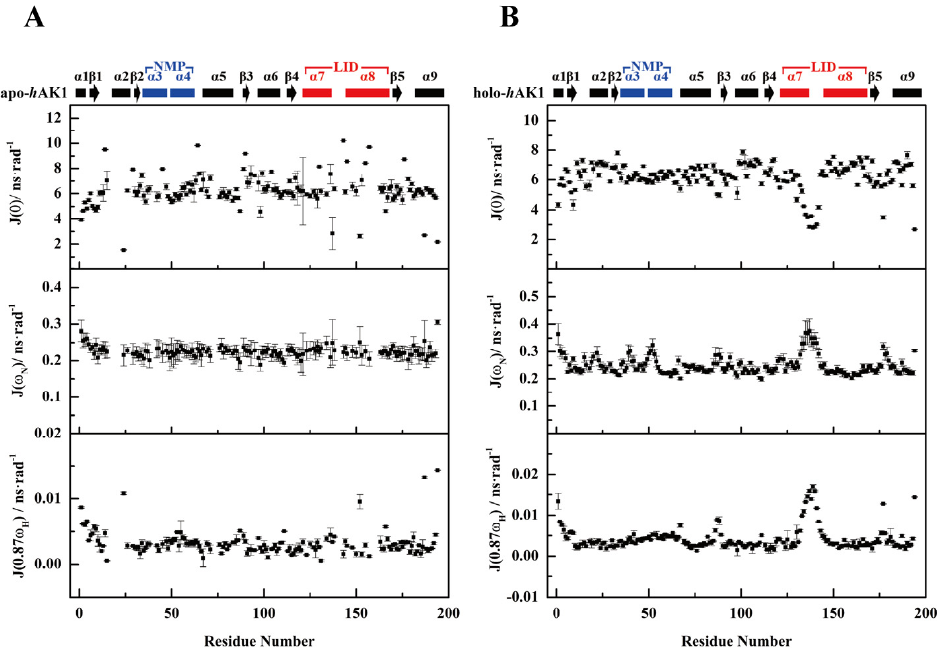
Figure 6. Spectral density functions of residues in apo- h AK1 ( A ) and holo- h AK1 ( B ). Analysis of